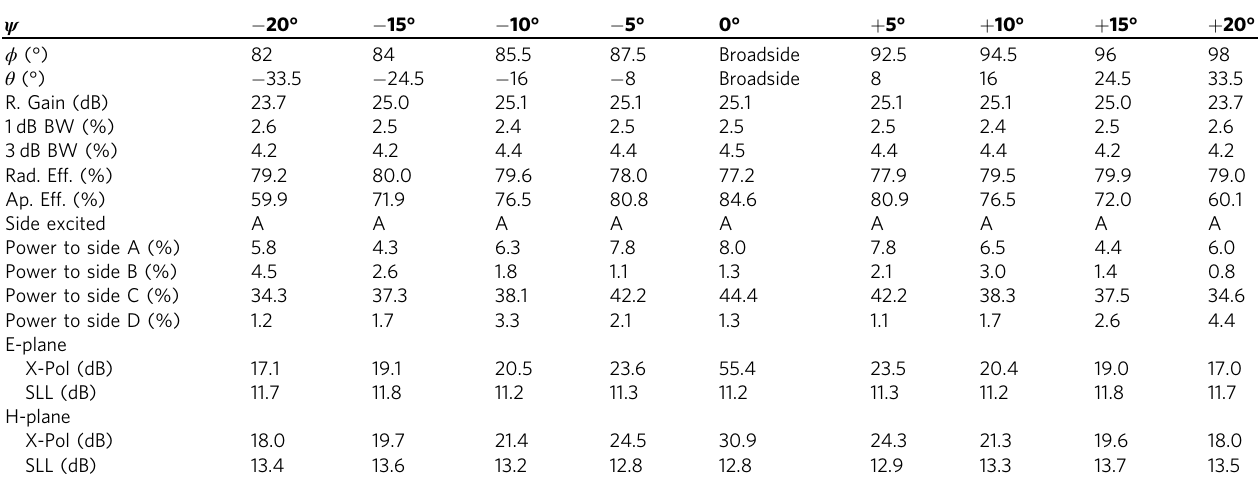
Table 1 Antenna parameters simulation. The full-wave simulated antenna parameters for a plane wave excited at various directions ( ψ ) inside the PEX